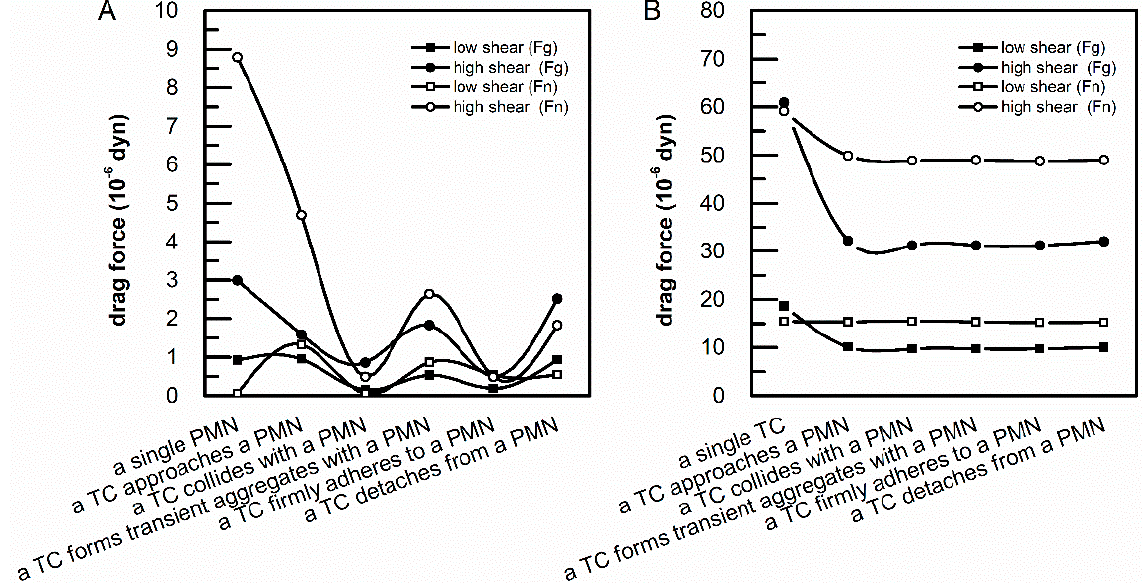
Figure 5. Drag force acting on adherent cells in the presence of soluble fibrin (ogen). ( A ) Above an adherent PMN; ( B ) Above an adherent TC. Solid squares ( ■ ) represent a low shear condition (91.25 μ L min − 1 ) with sFg, solid circles ( ● ) represent a high shear condition (292 μ L min − 1 ) with sFg, open squares ( □ ) represent a low shear condition (91.25 μ L min − 1 ) with sFn, and open circles ( ○ ) represent a high shear condition (292 μ L min − 1 ) with sFn.